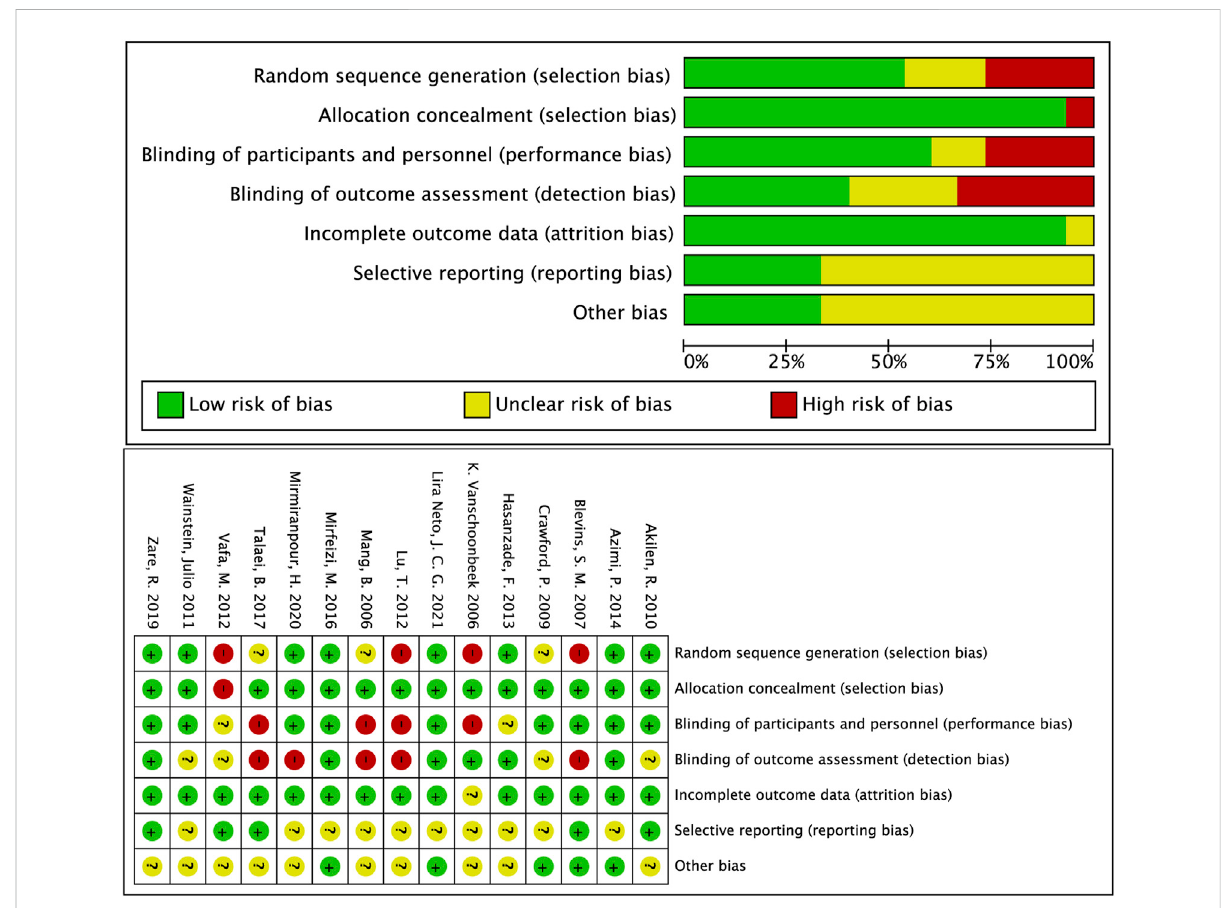
FIGURE 3 Overall summary of risk of bias in the included studies. +: low risk of bias; − : high risk of bias; ?: unclear risk of